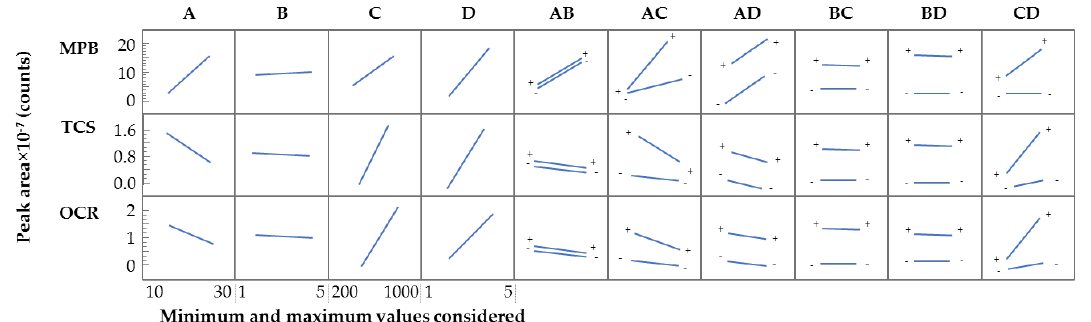
Figure 4. Effects of the main factors in the response (as the chromatographic peak area) for representative PCPs (MPB, TCS, and OCR), and the interaction among factors obtained in the screening analysis of the main variables that influence the D-µSPE-UHPLC-UV; where A is the amount of MOF, B is the extraction time, C is the volume of methanol, and D is the desorption